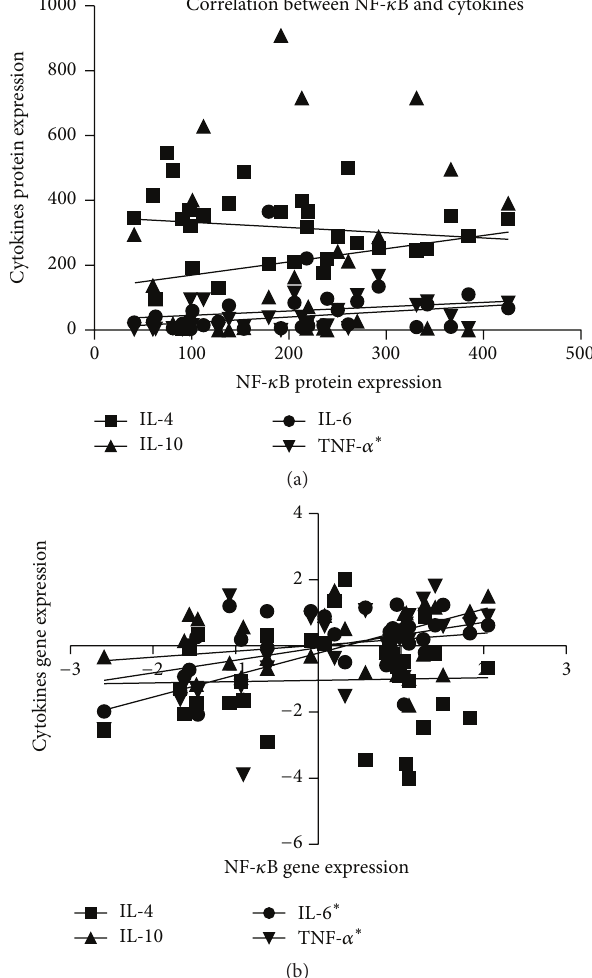
Figure 8: Spearman’s rank correlation analysis between proin- flammatory and anti-inflammatory cytokines with NF- 𝜅 B protein and gene expression: (a) positive correlation between NF- 𝜅 B pro- tein expression and the proinflammatory TNF- 𝛼 cytokine protein expression ( 𝑟 = 0.5233 ; 𝑝 = 0.003 ) and (b) NF- 𝜅 B gene expression and its correlation between the proinflammatory TNF- 𝛼 cytokine ( 𝑟 = 0.6645 ; 𝑝 < 0.0001 ) and IL-6 ( 𝑟 = 0.4012; 𝑝 = 0.02 ) gene expression. ∗ 𝑝 < 0.05